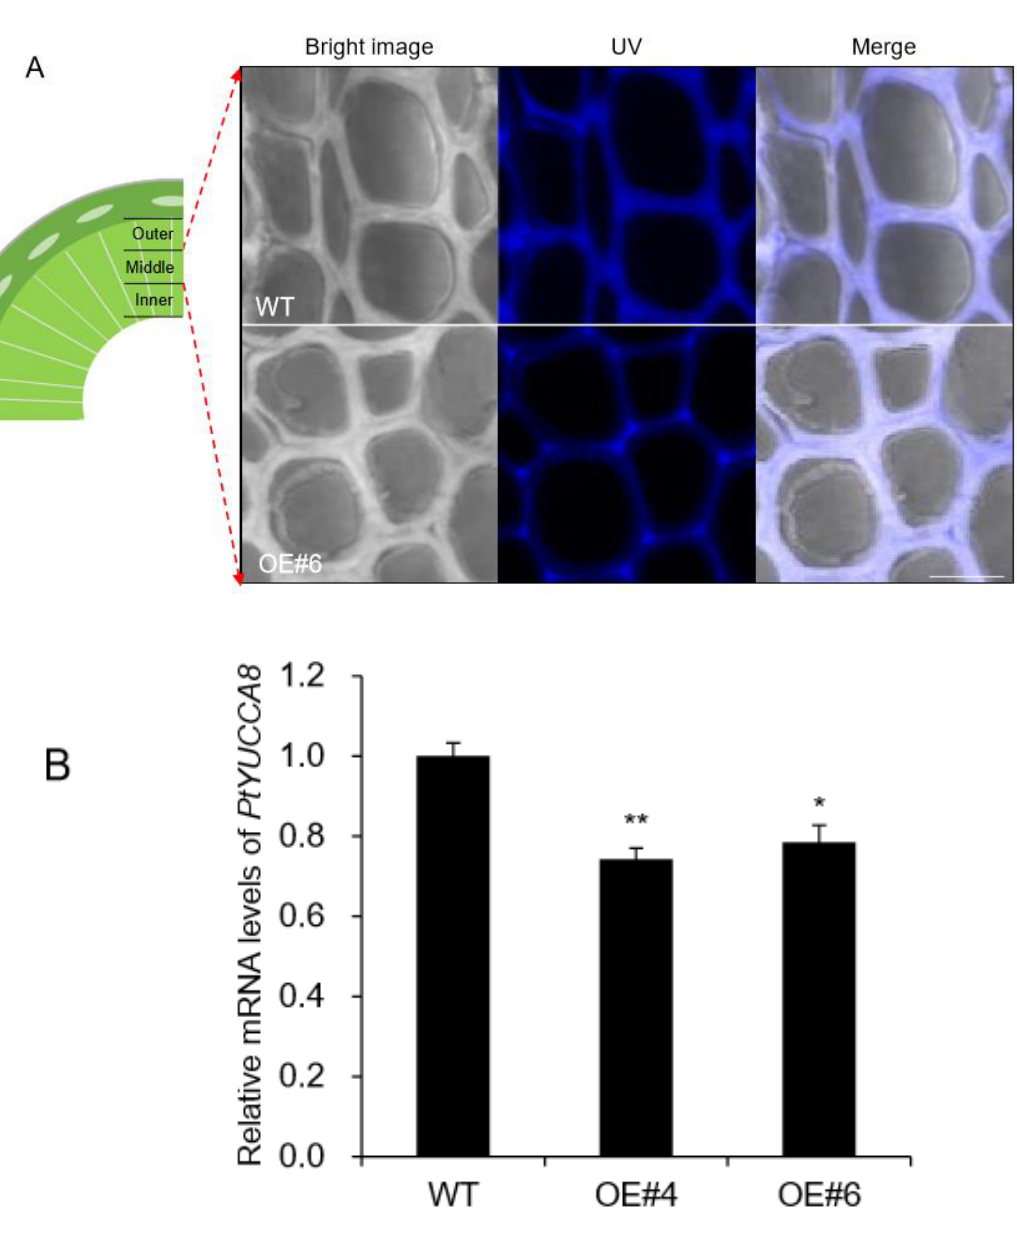
Figure 7. The middle xylem layer was altered in AtpPLAIII α - OE. ( A ) Enlarged images of portions of the middle xylem showed that the cell walls were thickened in OE, whereas the UV autofluorescence signal was weakened compared to that of WT. Bright image, UV, and merged images of WT and OE were displayed. Bar = 10 µ m. ( B ) Expression levels of PtYUCCA8 in basal xylem part of stem in WT and AtpPLAIII α -OE. Each datum represents the average ± SE from three independent replicates at P < 0.05 (*) and P < 0.01 (**), respectively.